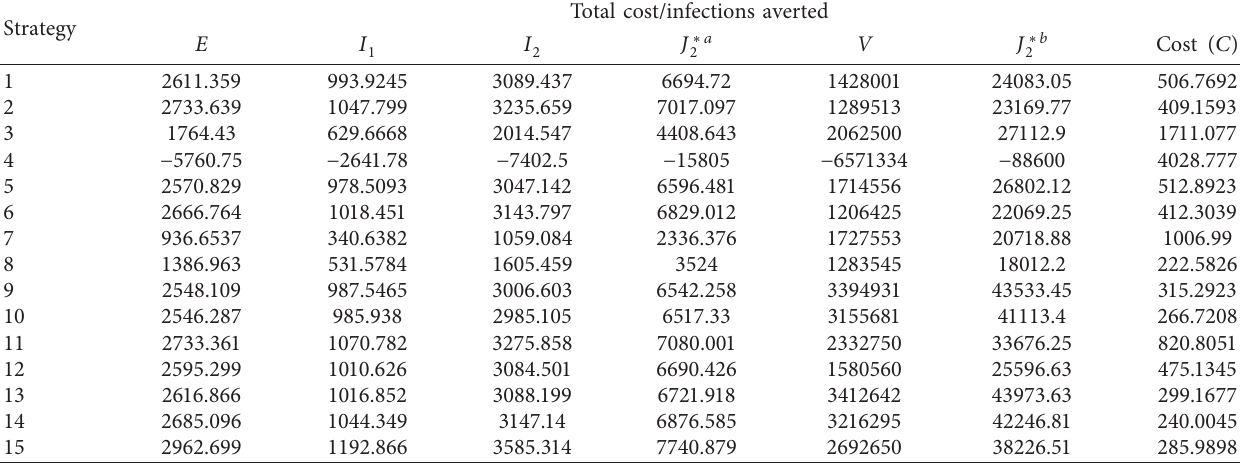
Table 4: Results from the simulation of the optimal control problem.